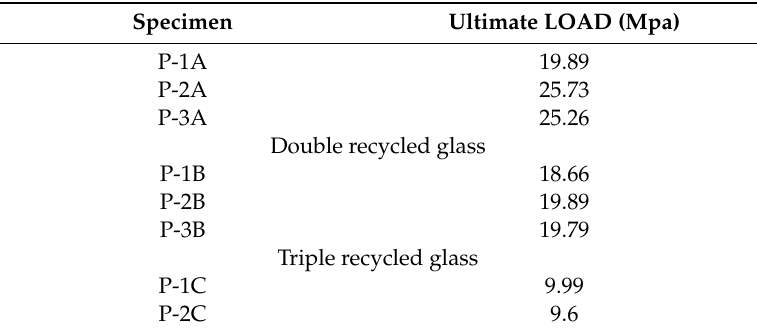
Table 7. Ultimate loads reached from compression tests.